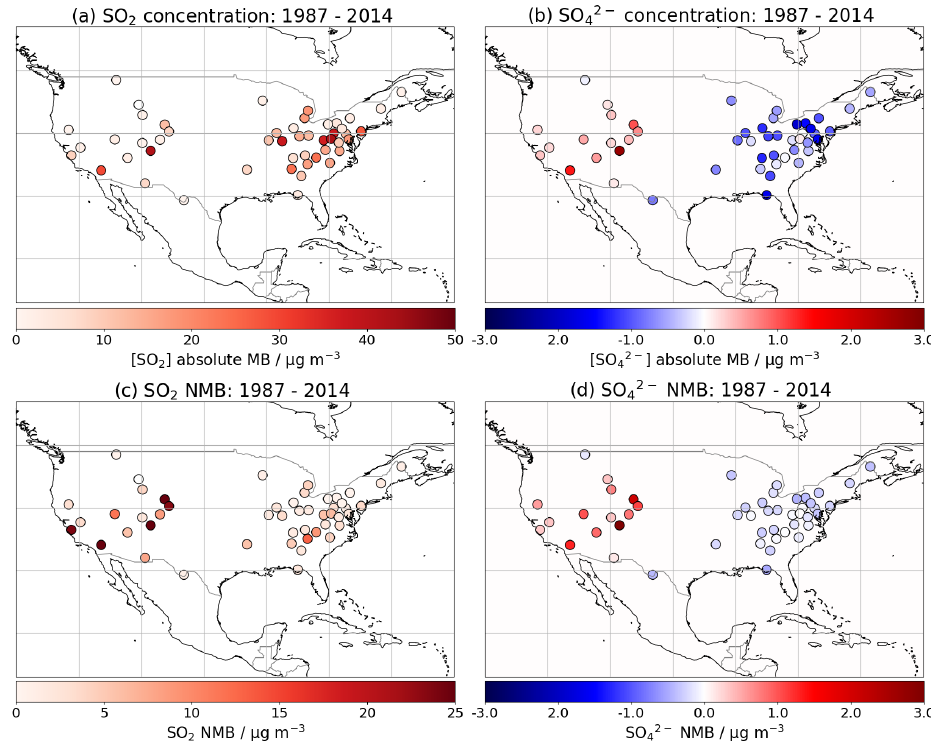
− concentration at 49 CASTNet 4